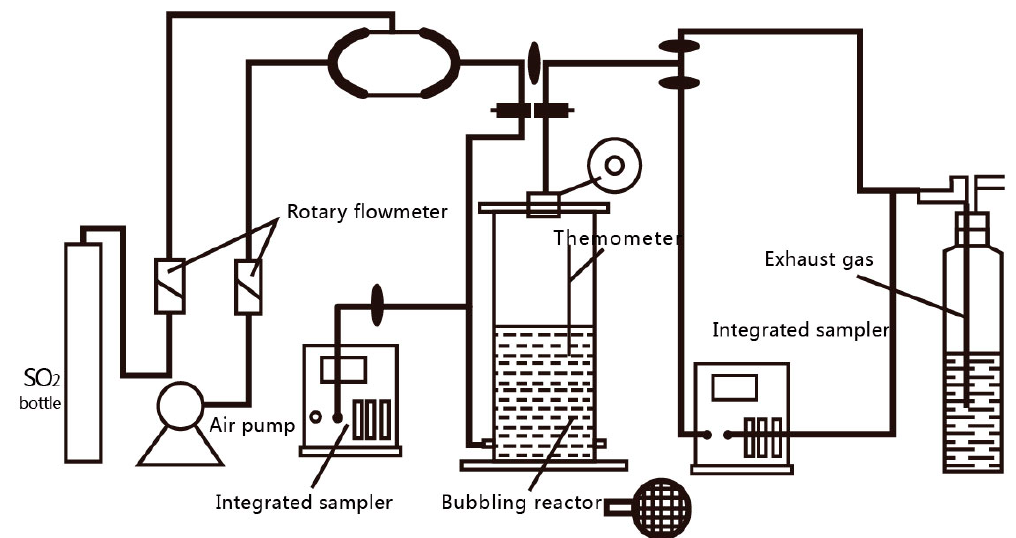
Figure 5. Structure of the test device.